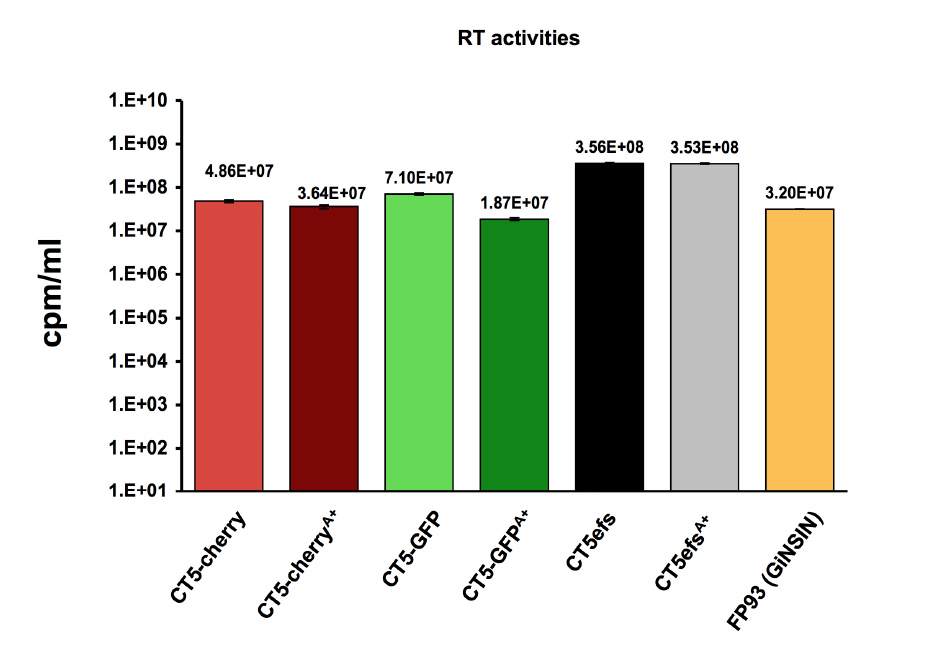
Figure 2. Virus production. Supernatant reverse transcriptase activities of the different reporter viruses. For vector GiNSIN, the source of RT activity is the packaging plasmid pFP93 used to trans-package the transfer vector [6,40]. Background RT activities determined in supernatants of un-transfected control cells, which were between 0.1–1 % of transfected cell supernatant values, were subtracted before graphing. Error bars represent standard deviation of duplicate